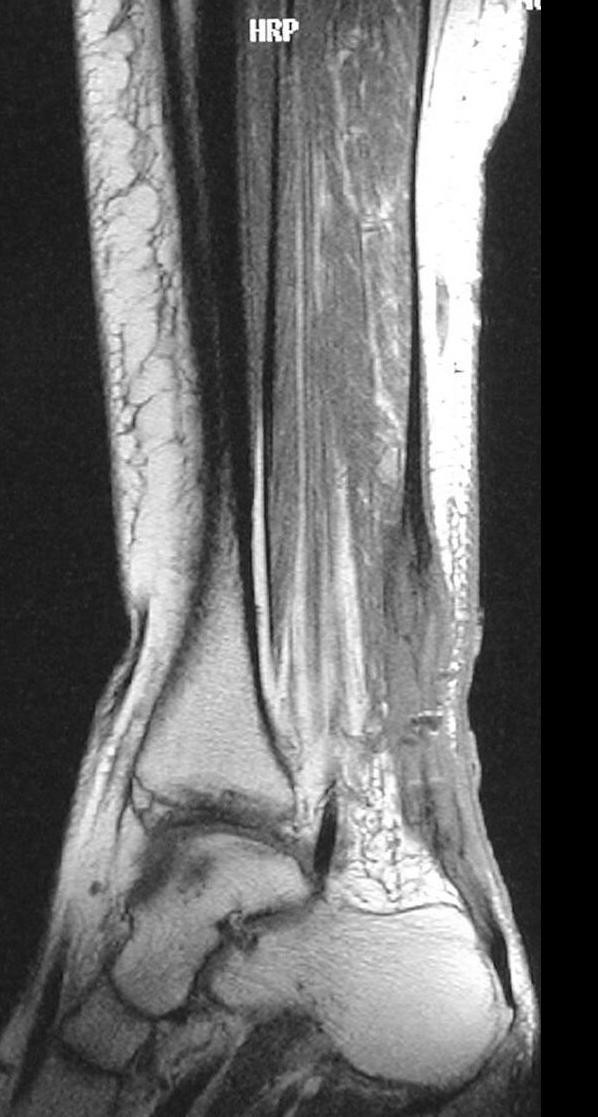
MRI scan one week after open repair of the Achilles tendon. Note the fracture line of the medial malleolus.